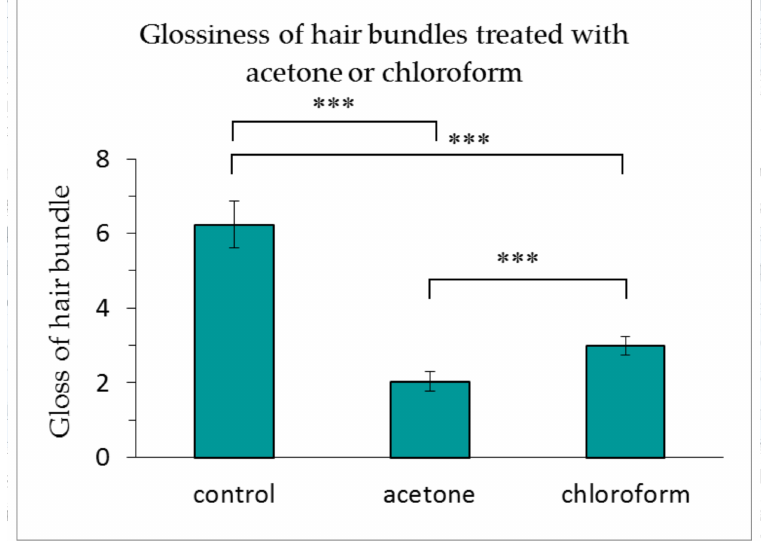
Figure 5. Glossiness of hair bundles treated with acetone or chloroform. The results are expressed as the mean ± standard deviation from 10 experiments. ∗∗∗ p <